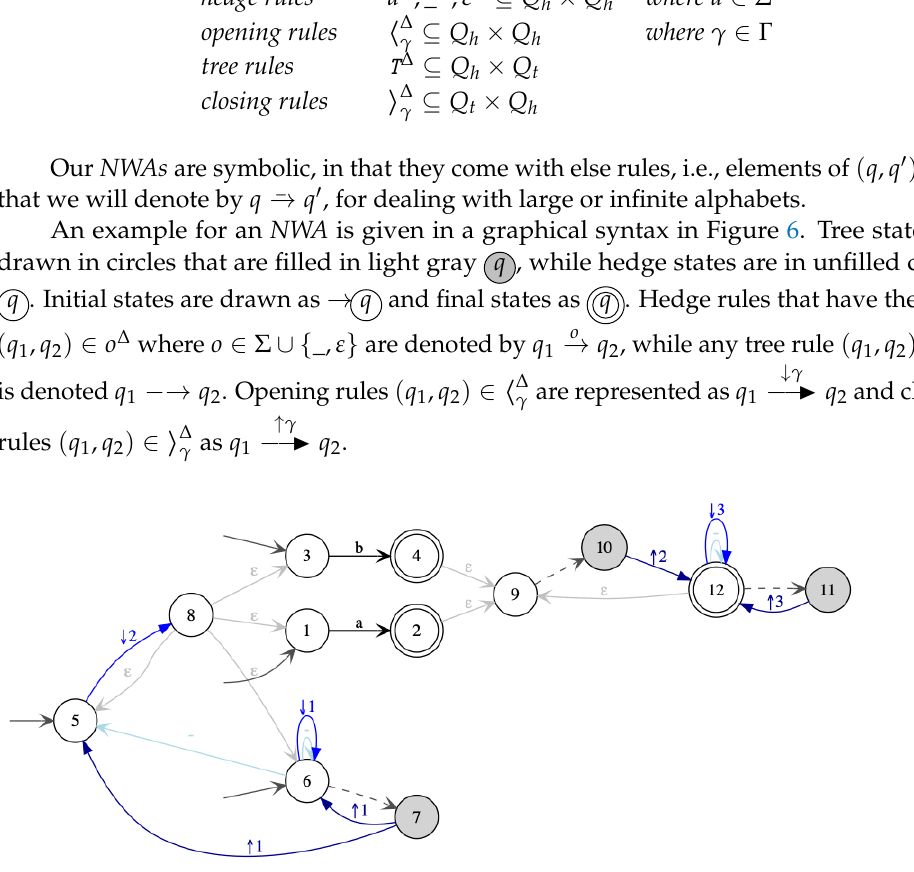
Figure 6. Nested word automaton nwa ( ch ∗ ( a + b ))